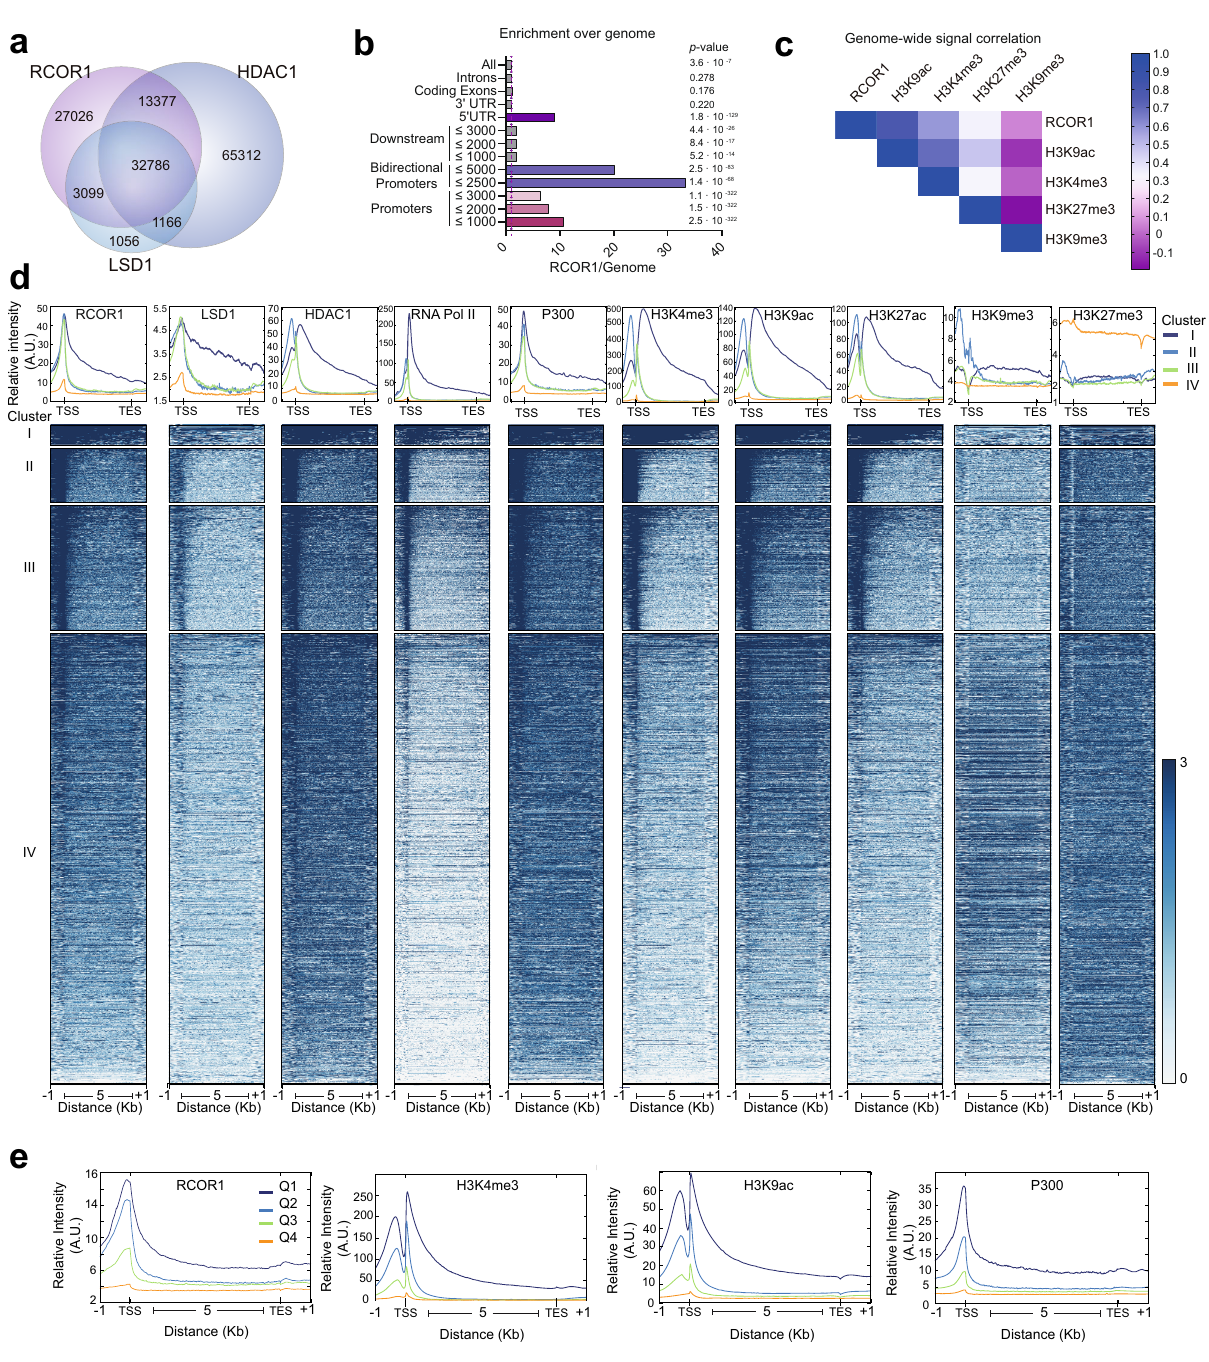
Fig. 3 RCOR1 is enriched in proximal promoters of active genes. a Venn diagram showing the number of ChIP-seq peaks of RCOR1, LSD1, and HDAC1 on K562 cells. b Enrichment of ChIP-seq peaks on DNA elements over the natural abundance of these elements across the genome. Dashed violet line shows enrichment over genome abundance. P values are shown next to each bar. c Genome-wide signal correlation heatmap showing the Spearman correlation coef fi cient between genome-wide signals of RCOR1 and different histone modi fi cations. d Meta-gene pro fi ling of RCOR1, LSD1, HDAC1, RNA POL-II, P300, and histone modi fi cations in K562 cells. Upper plots show the normalized signal pro fi les for the occupancies of each protein or modi fi cation analyzed in different RCOR1 clusters. Lower plots show the signal heatmap from the genes in the four clusters. e Quartile-based comparison of relative occupancies of RCOR1, H3K4me3, H3K9ac, and P300 on RCOR1-sorted gene quartile